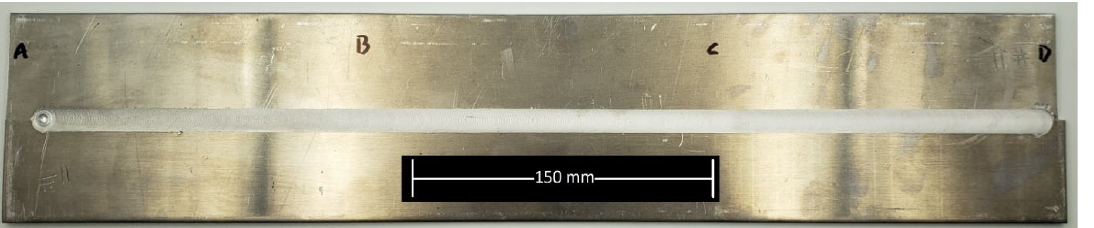
Figure 2. An example of a friction stir weld produced for spectral analysis. This specific weld was produced with parameter set 4 in Table 1. Table 1. Traverse velocity and welding tilt varied throughout the experiments and all combinations are included here.